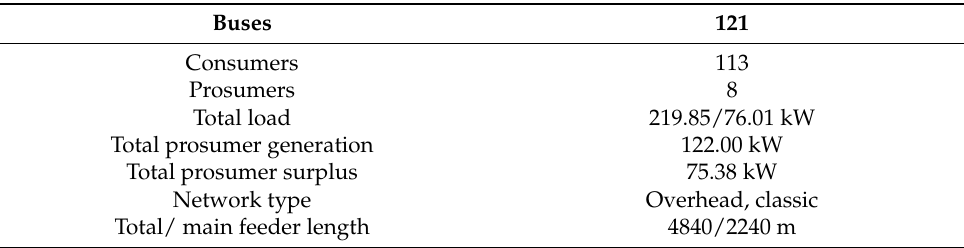
Table 2. Summary data for network R121.